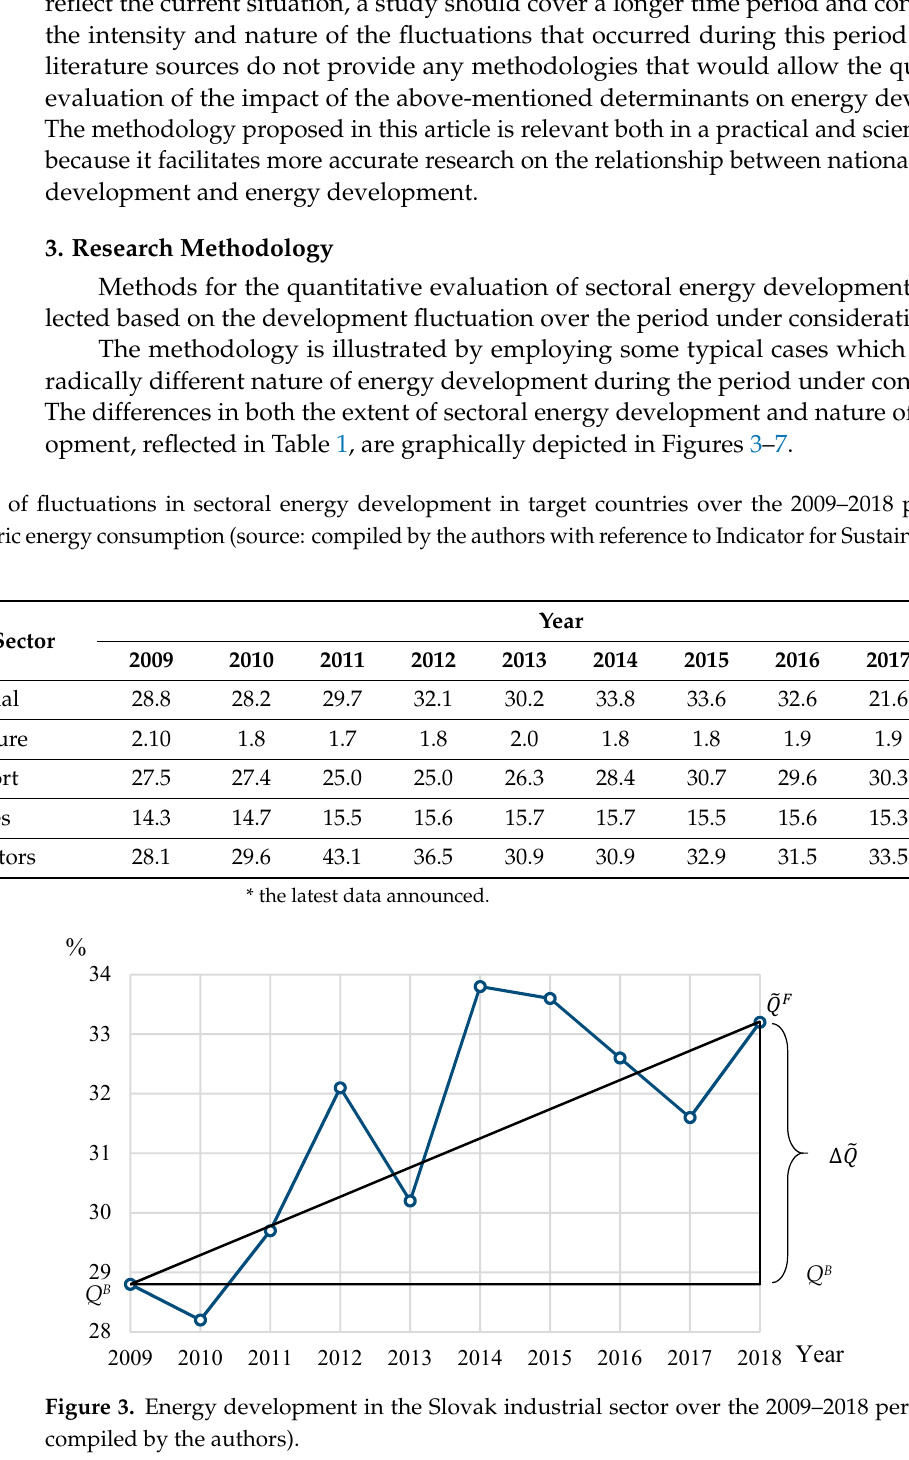
Figure 4. Energy development in the Belgian agricultural sector over the 2009 – 2018 period (source: compiled by the authors). . Figure 5. Energy development in the Lithuanian transport sector over the 2009 – 2018 period (source: compiled by the authors).